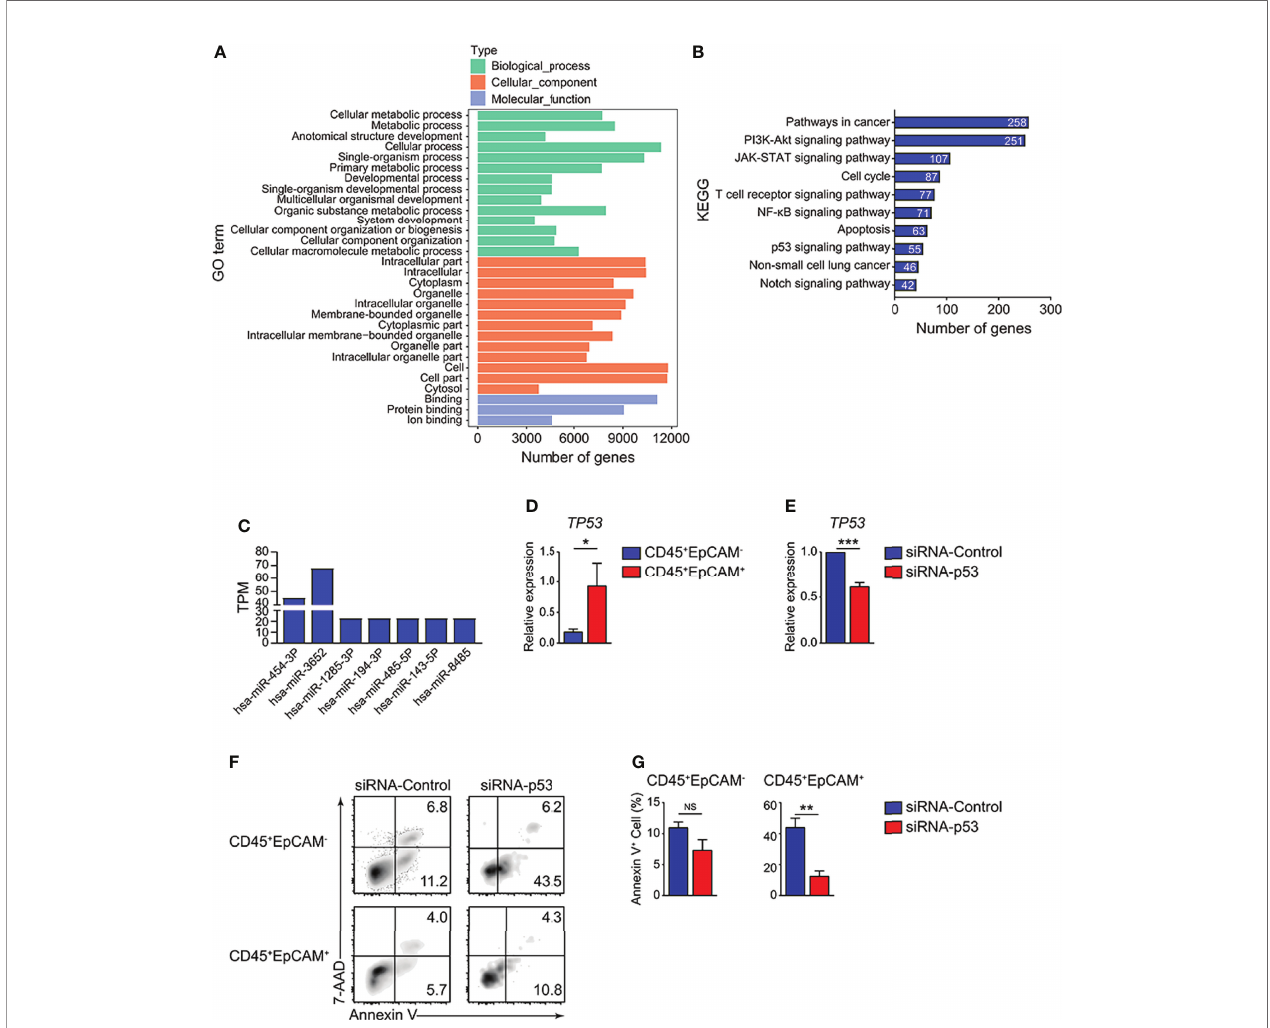
FIGURE 6 | HCC827 cell-derived exosomes promote CD45 + EpCAM + cell apoptosis via the p53 pathway. (A) GO function analysis for miRNA-targeted genes in HCC827 cell-derived exosomes. (B) KEGG pathway analysis of miRNA-targeted genes in HCC827 cell-derived exosomes. (C) Expression of miRNAs targeting gene TP53 in HCC827 cell-derived exosomes. (D) Quantitative RT-PCR analysis of the cell apoptosis-related gene, TP53 , in CD45 + EpCAM + and CD45 + EpCAM − cells from PBMCs cultured with HCC827 cell conditioned media ( n ≥ 4). (E) Quantitative RT-PCR analysis of TP53 in siRNA-control group and siRNA-p53 group from PBMCs cultured with HCC827 cell conditioned media ( n = 3). (F, G) Flow cytometry analysis of Annexin V + cells gated on CD45 + EpCAM − (top panel) and CD45 + EpCAM + cells (bottom panel) from PBMCs cultured with HCC827 cell conditioned media, treated with siRNA-control or siRNA-p53 treatment respectively. Data are presented by typical density plots and quanti fi cation data shown in (F, G) , ( n = 3). Data are representative of at any rate two separate experiments. Error bars delegate SEM. * P < 0.05, and ** P < 0.01, and *** P < 0.001 (Student ’ s t -test). NS, no signi fi